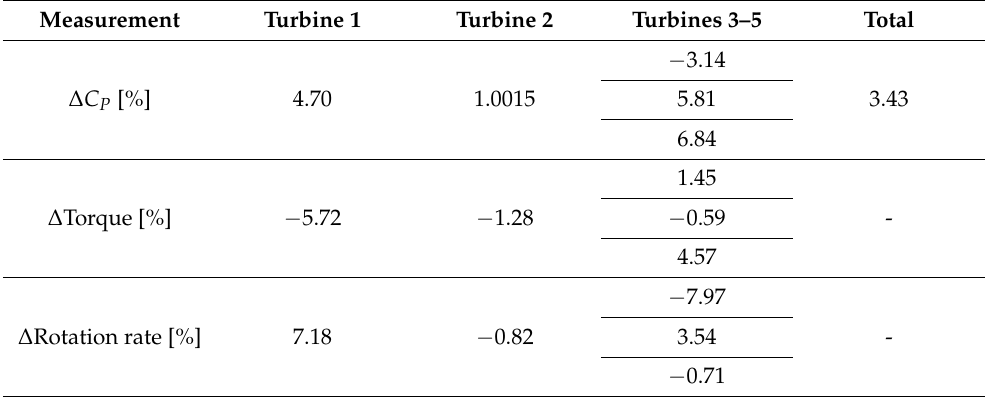
Table 2. Percent differences (treatment minus control normalized by treatment) in the coefficients of power, torques, and rotation rates. All differences are significant at the 95% confidence level.